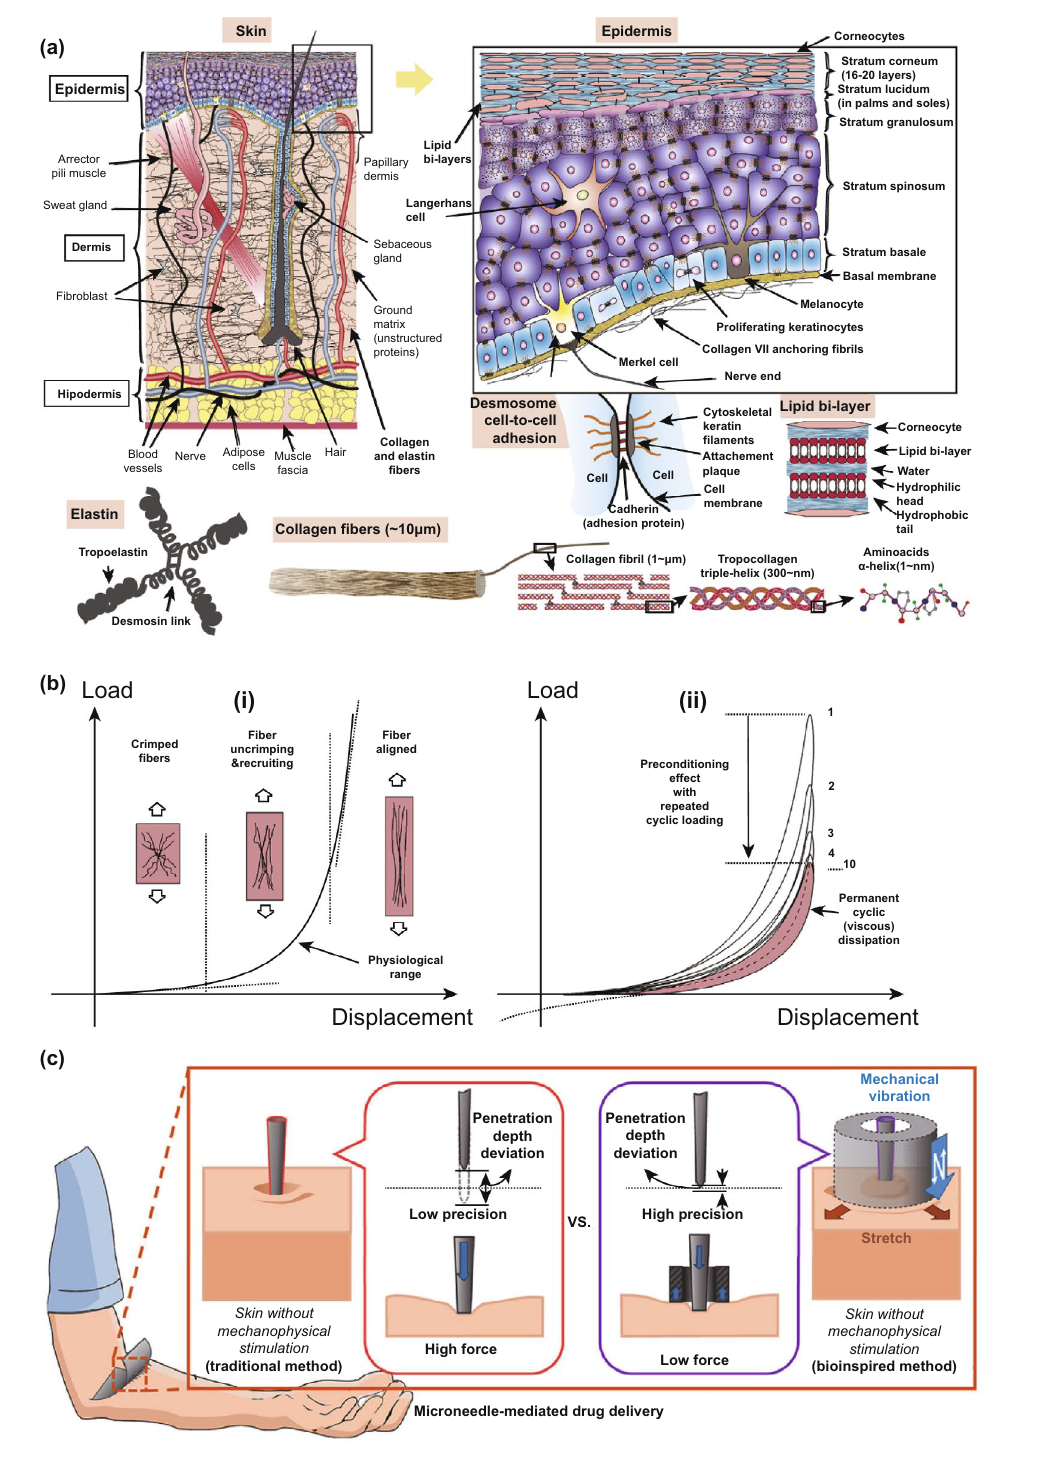
Fig. 2 a The structures of the skin and its layer. b Stress–strain behavior of soft tissues during tensile tests: (i) preconditioned hyperelastic behavior and (ii) preconditioning and viscous effects. Reprinted from Ref. [39] with permission from Elsevier. c Impact of changing skin resist- ance to microneedle penetration. Reprinted from Ref. [40] with permission from